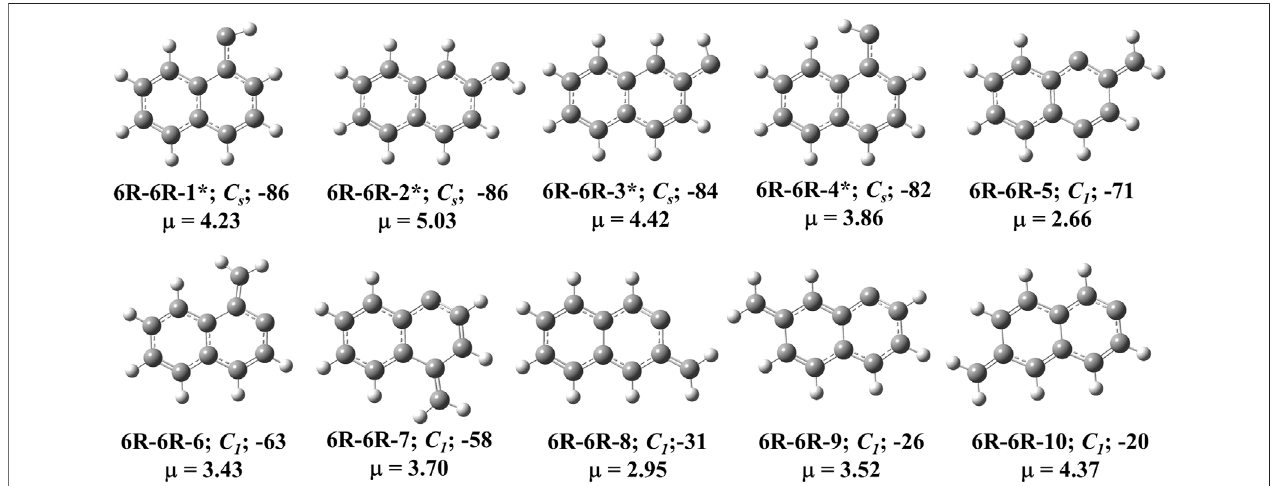
FIGURE 3 | First ten low-lying C 11 H 8 carbenes/cyclic allenes isomers of (6R-6R) group. ZPVE-corrected relative energies (in kJ mol − 1 ), absolute dipole moment values (in Debye) are calculated at the B3LYP/6-311 + G (d,p) level of theory. Experimentally detected isomers are marked with an asterisk symbol.